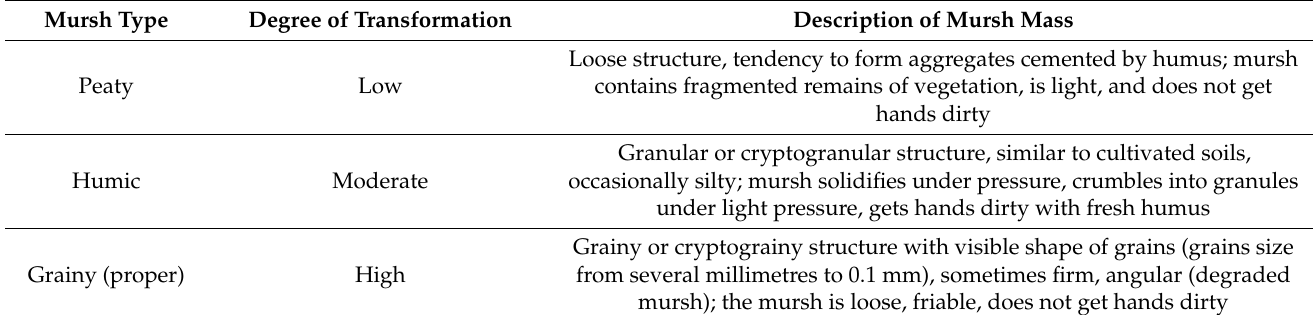
Table 1. Classification of murshes according to the degree of transformation of the mass taking into account its